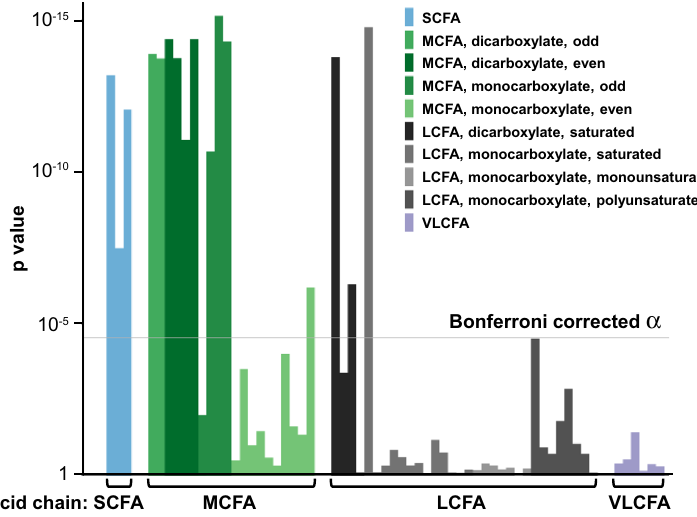
Figure 3. Comprehensive analysis of Fatty Acid associations with a recent history of persistent normoalbuminuria phenotype. The needle plot depicts p values obtained with the logistic regression analysis adjusted for clinical covariates following their logarithmic base 10 transformation. Each needle represents an individual Fatty Acid. Fatty Acids are ordered by chain length categories, followed by structural features. The grey line marks the threshold of significance at Bonferroni corrected α = 0.000028. SCFA Short Chain Fatty Acid, MCFA Medium Chain Fatty Acid, LCFA Long Chain Fatty Acid, VLCFA Very Long Chain Fatty